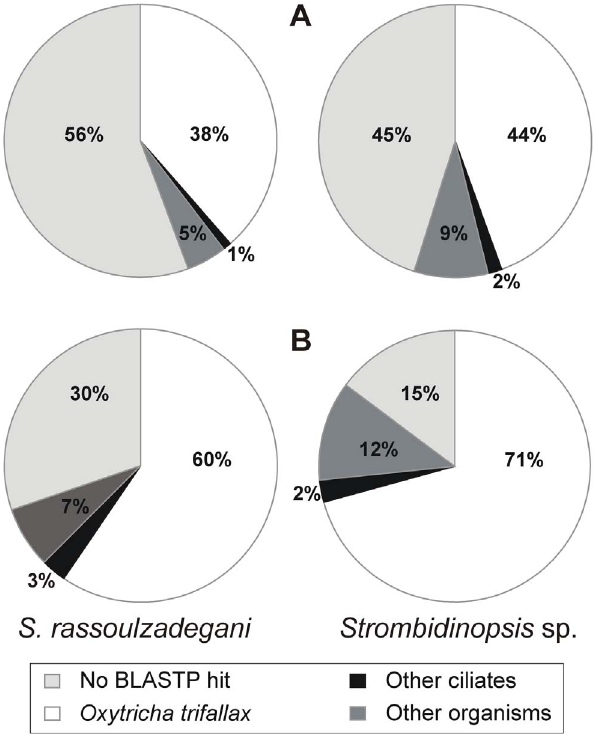
Figure 2. BLASTP hit distribution in ciliate transcripts. A- Proportion of amino acid sequences. B- Proportion of Illumina reads realigned to the corresponding coding regions.